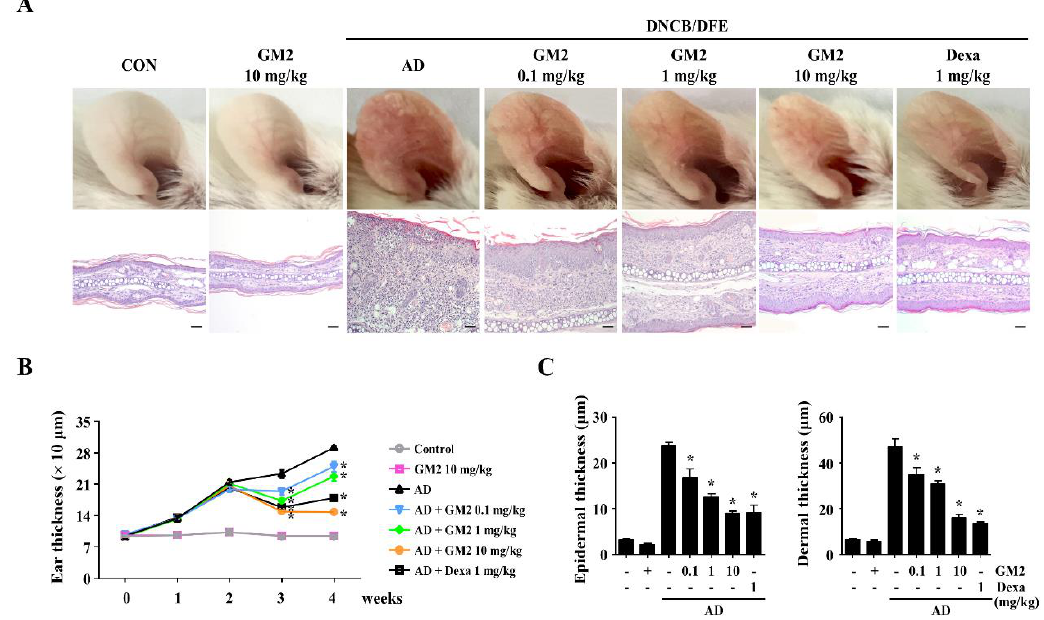
Figure 2. Representative atopic dermatitis (AD) lesion images and effects of GM2 on the ear thickness of AD mice. ( A ) Representative images demonstrated AD-like skin lesions (upper panel) in the different experimental mice groups and representative photomicrographs of the ear sections were stained with H&E (down panel, scale bar = 20 μm, magnification 200×) from the DNCB/DFE-induced mouse model. ( B ) Ear thickness was measured using a 7301-dial thickness gauge. ( C ) The epidermal and dermal thickness was measured using the stage micrometer 10:100 in the H&E-stained tissue slides. Data are presented in the graph and are the means ± SEM ( n = 5). * p < 0.05, compared with the DNCB/DFE-induced group. Dexa: dexamethasone.